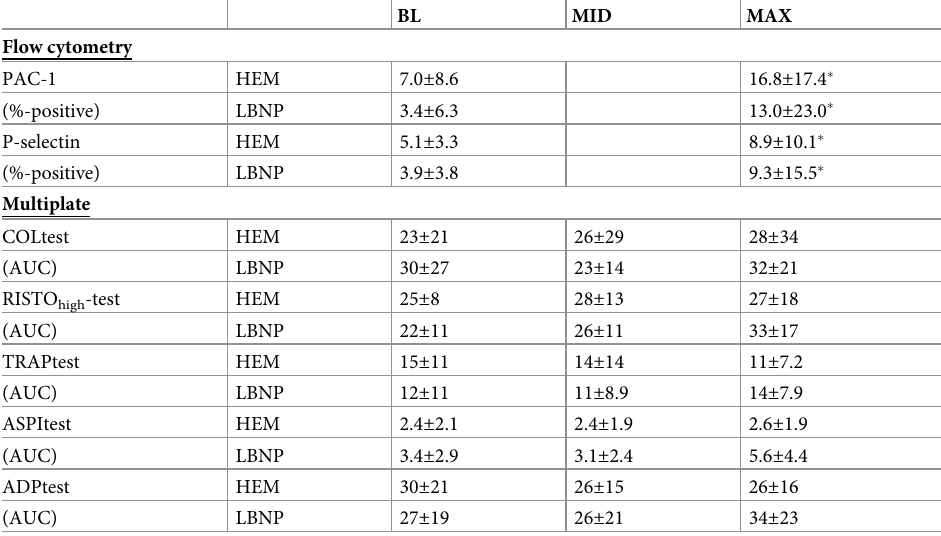
Table 2. Platelet activity and function before and during HEM and LBNP analyzed by flow cytometry and Multiplate.